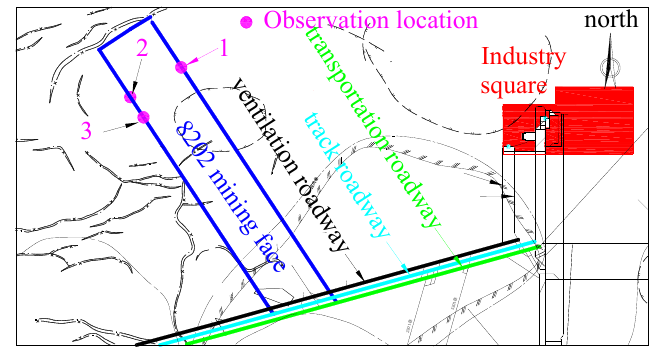
Figure 3. Plan view of panel 8202 layout.